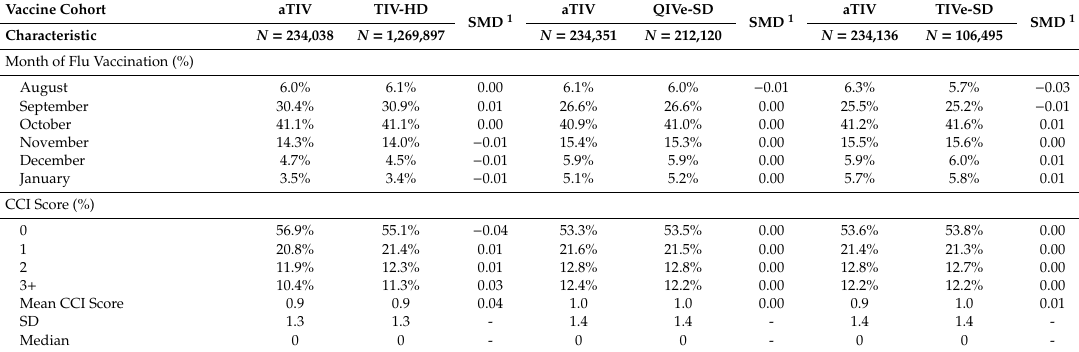
Table 2. Baseline clinical